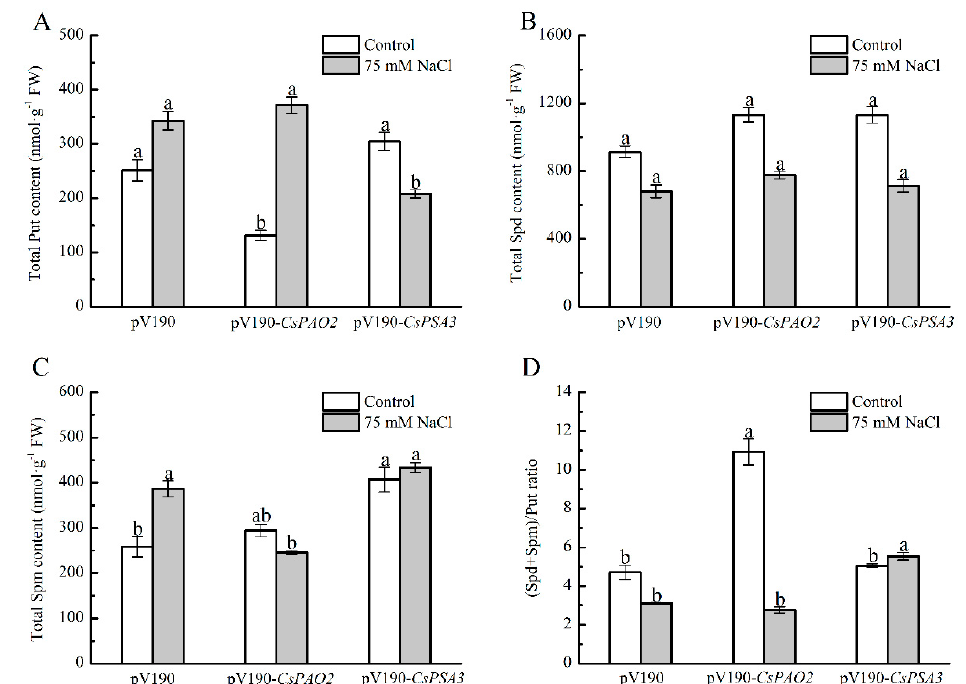
Figure 6. Effects of CsPAO2 and CsPSA3 silencing on polyamine content in leaf of salt-treated cucumber. ( A ) Put; ( B ) Spd; ( C ) Spm; ( D ) (Spd+Spm)/Put ratio. Gene-silencing plants cultivated in nutrient solution were treated with 75 mM NaCl for 3 days. The different letters indicate significantly different test index values between different gene-silencing cucumber plants under the same treatment ( p < 0.05) according to Tukey’s test.